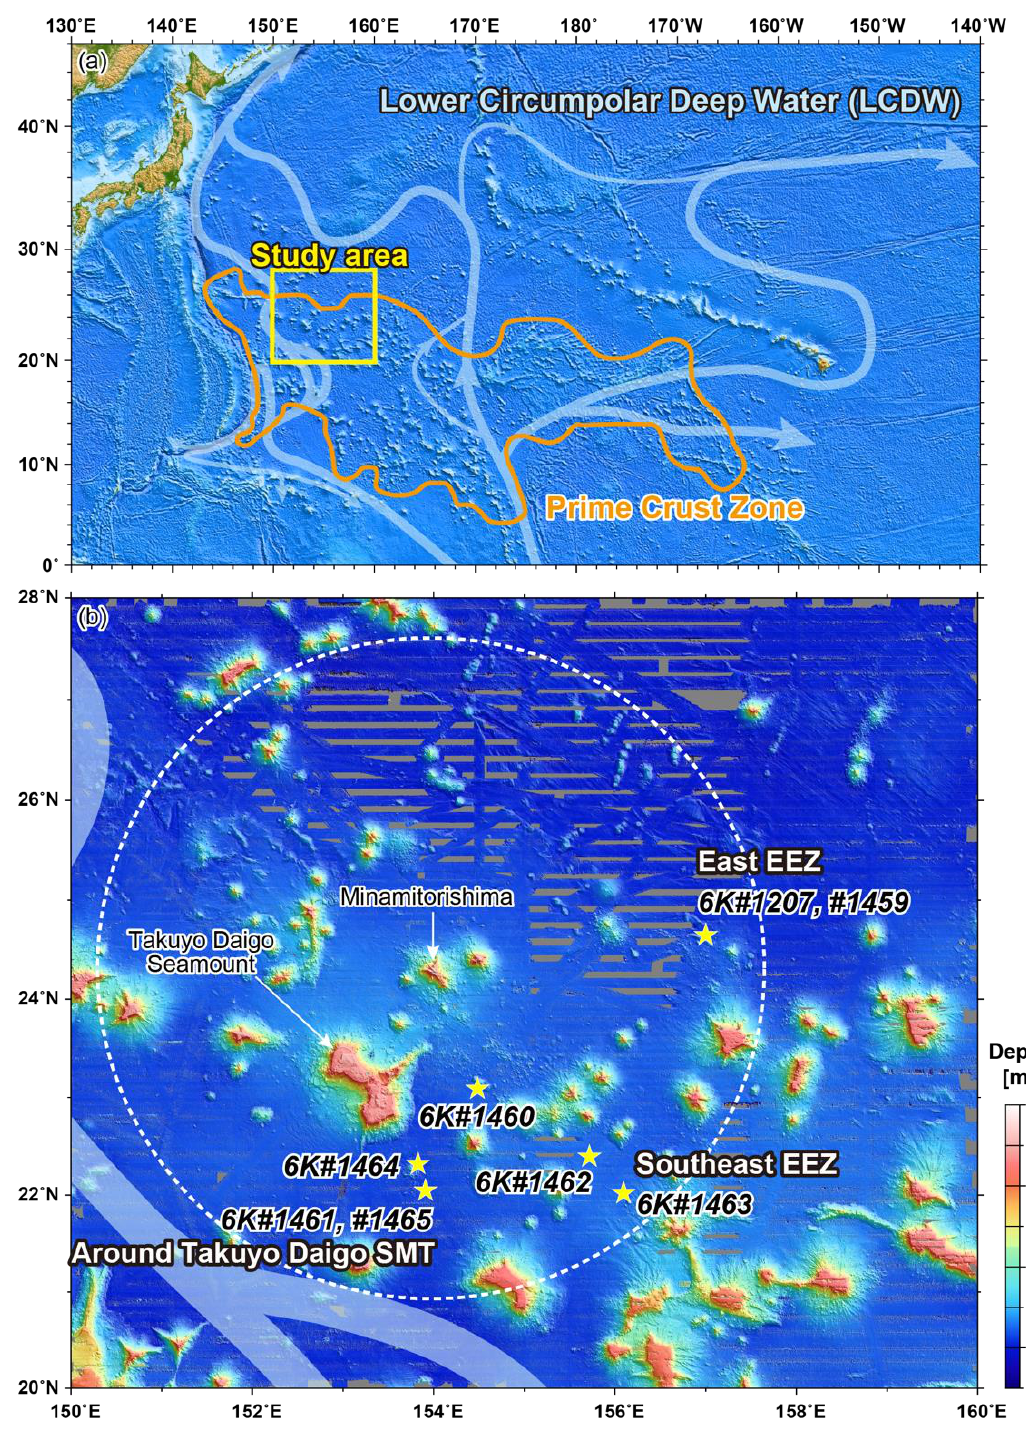
Figure 1. Topography of the regions surrounding the Minamitorishima island. ( a ) Light blue arrows indicate the present circulation of the Pacific Ocean in the lower deep layer originated from the Lower Circumpolar Deep Water (LCDW) [21,22]. The region outlined by the orange line indicates the Prime Crust Zone defined by [12]. Topographic data are from ETOPO1 (NOAA National Geophysical Data Center; https://www.ngdc.noaa.gov/mgg/global/, accessed on 8 November 2021). ( b ) The stars indicate the locations of the sampling sites (submersible SHINKAI 6500 dive sites) during the cruises YK10-05 (6K#1207) and YK16-01 (other dives) of the R/V Yokosuka . The colored fine-scale topographic data of a vessel equipped with a multiple narrow-beam echo sounder (MBES) were obtained by Nakamura et al. [24]. The white dashed line indicates the Japanese exclusive economic zone around Minamitorishima island.